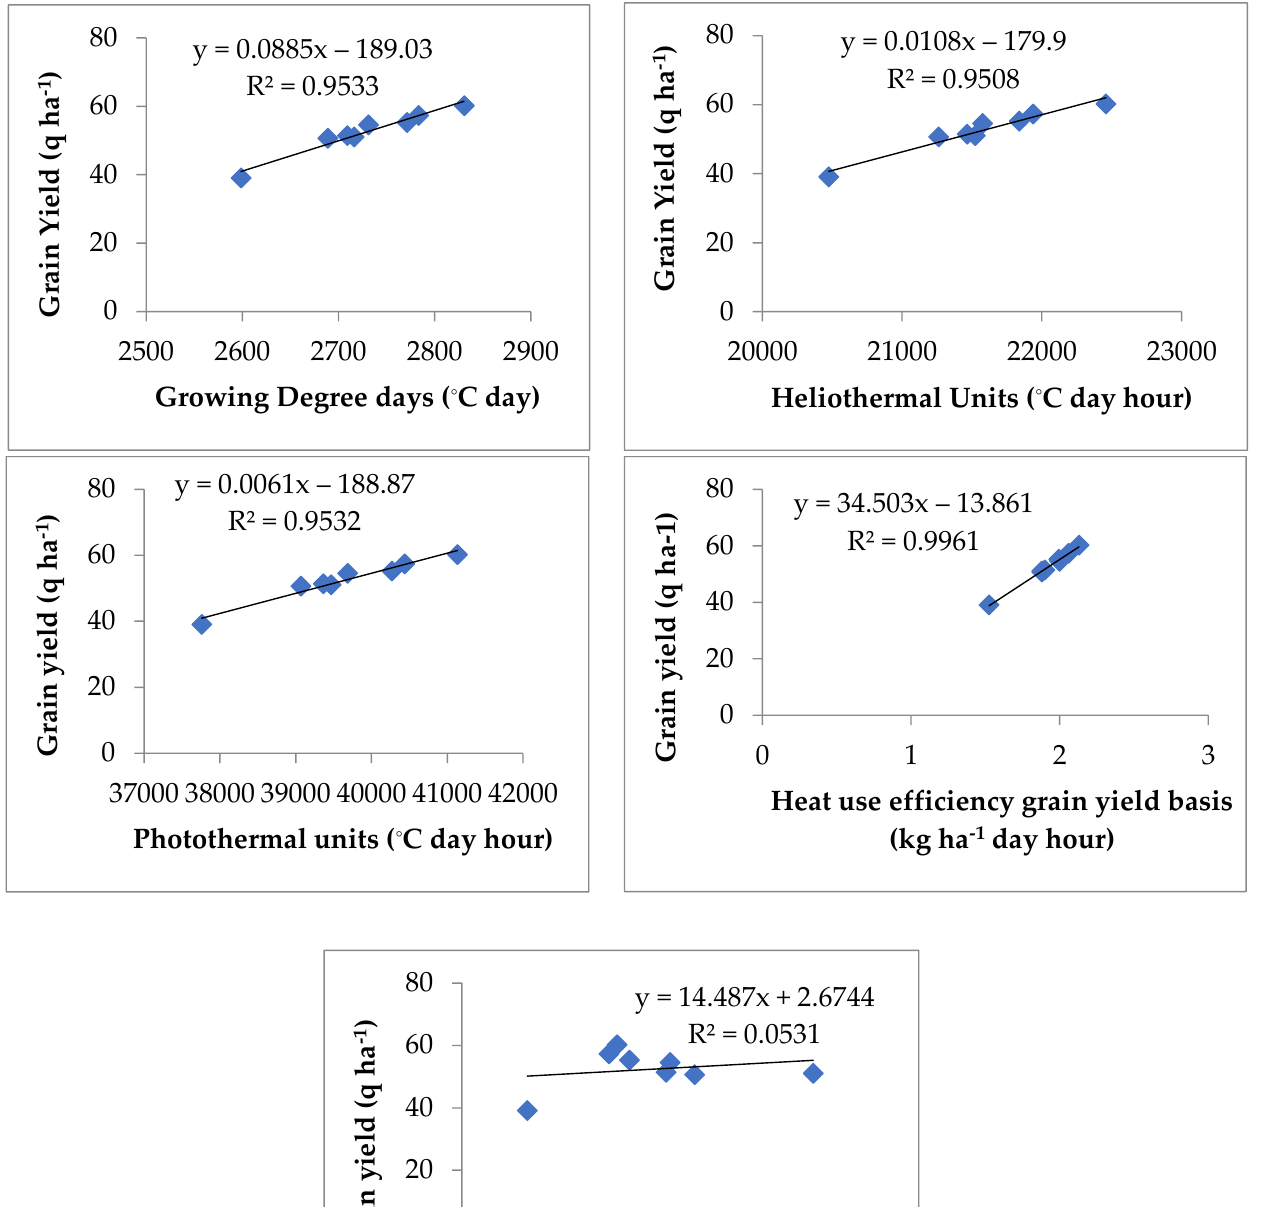
y = 0.0885x – 189.03